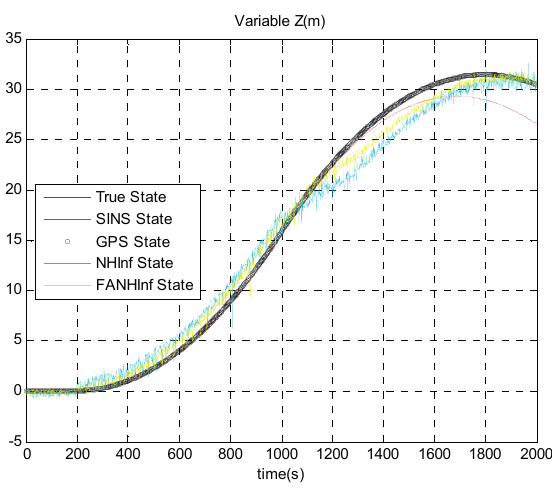
Figure 6. Estimation of the position Z .